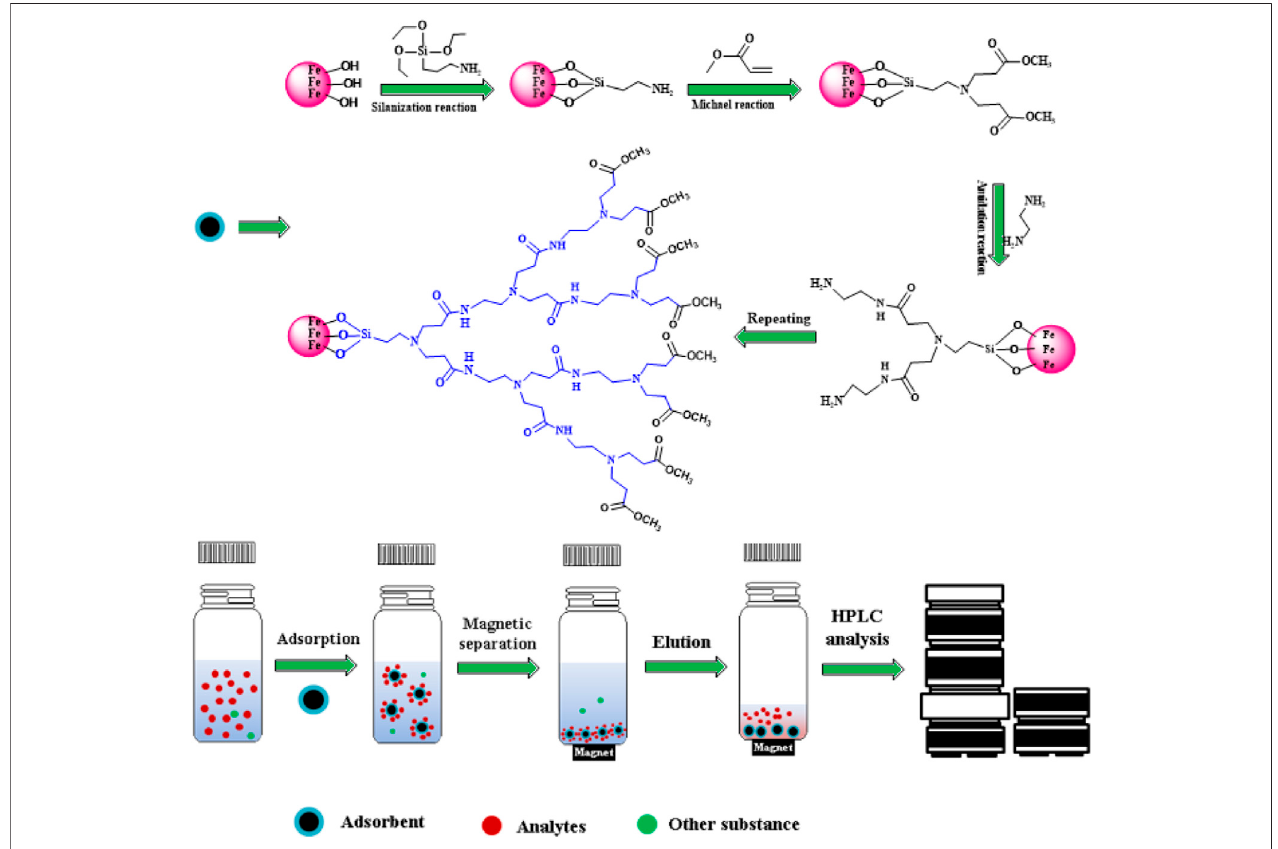
FIGURE 1 | Schematic diagram of the preparation of